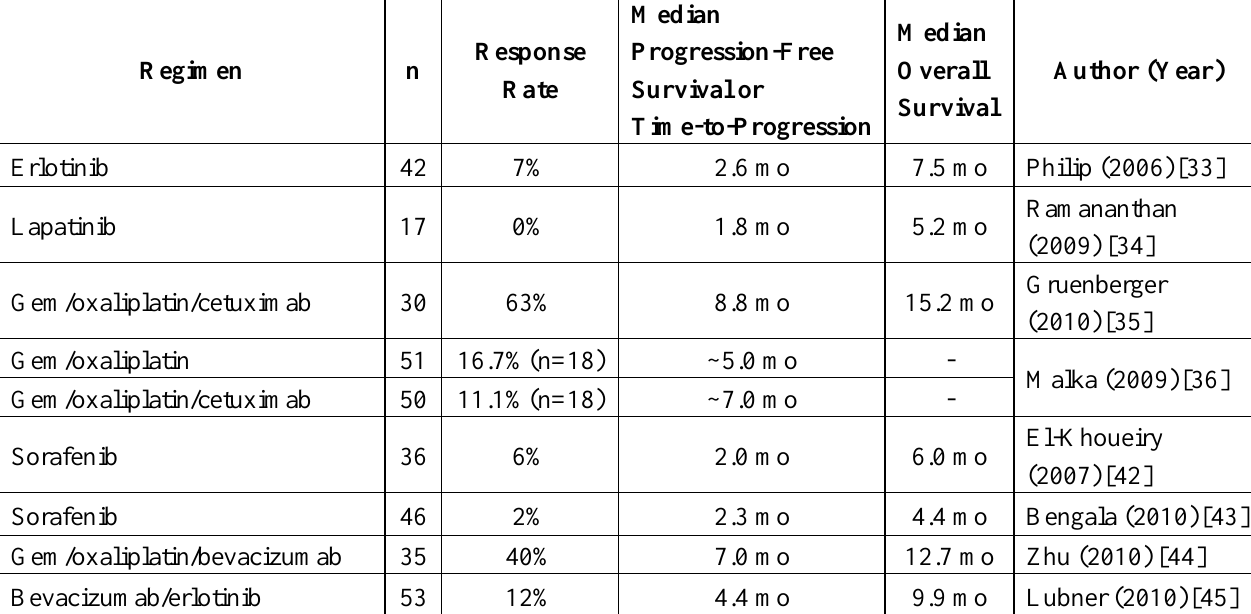
Table 3. Clinical trials of molecular targeted agents for unresectable biliary tract cancer.